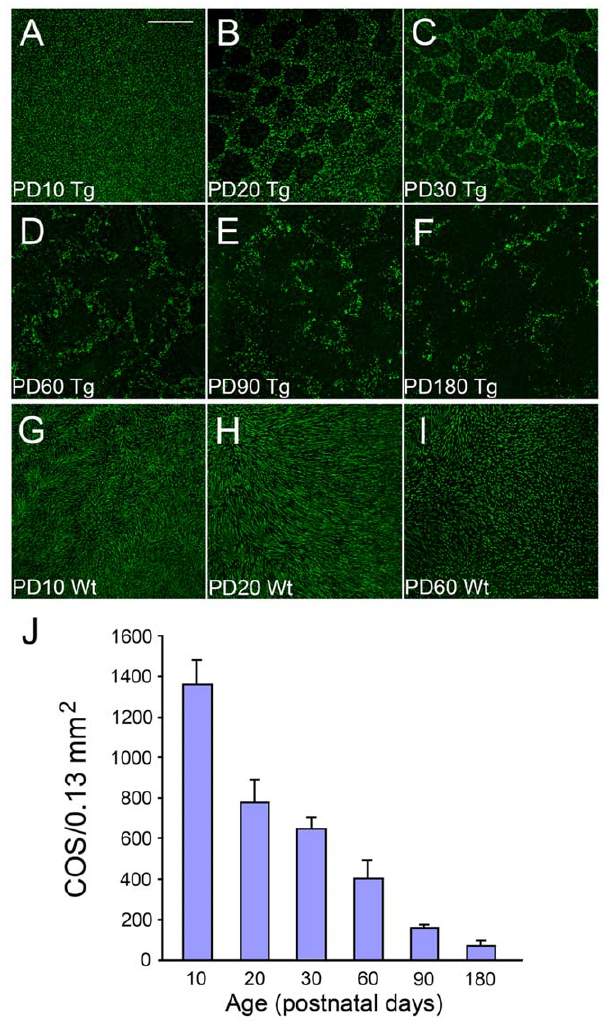
Figure 3. Loss of COS in the retinas of S334ter-3 rats. Whole- mounted retinas (superior regions) of S334ter-3 rats (Tg) are shown at PD 10 (A), 20 (B), 30 (C), 60 (D), 90 (E), and 180 (F), as well as retinas of wild-type (Wt) rats at PD10 (G), 20 (H), and 60 (I). Retinas were stained with PNA and examined by confocoal microscopy. In S334ter-3 retinas, loss of PNA staining is concentrated in small round or irregularly shaped areas. The loss of PNA staining was progressive with age (A–F). Quantitative analysis of the density of PNA positive cells in the S334-ter- 3 retinas clearly shows the progressive loss of PNA positive cells in the superior retina (J, mean 6 SD, n=4). No such loss of PNA positive cells was found in wild-type retinas (G–I). Scale bar: 200 m m.